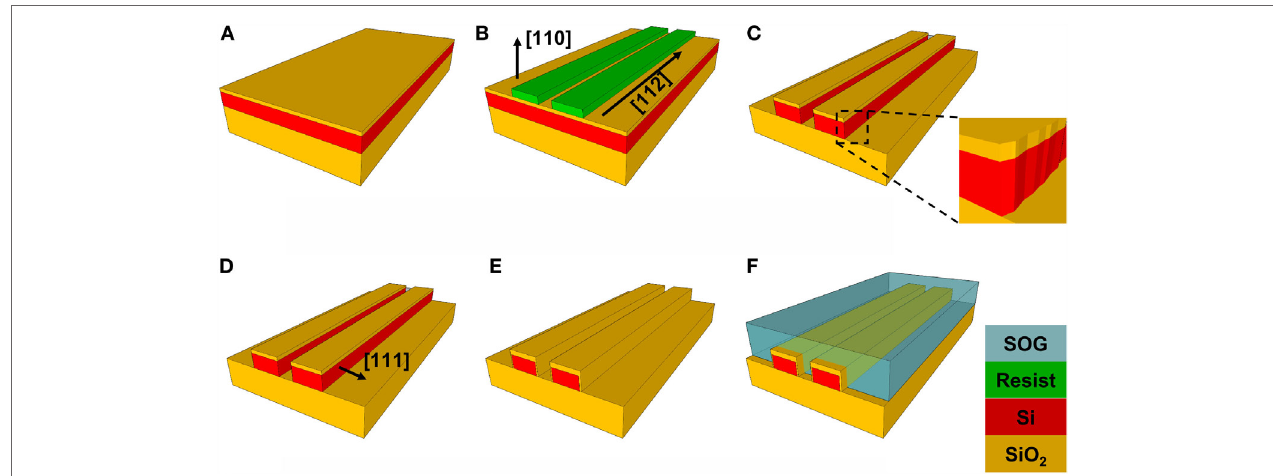
FigUre 2 | Fabrication process flow: (a) a 20-nm thick layer of siO 2 was thermally grown on sOi substrate; (B) slot and strip waveguide patterns were written on the resist layer using e-beam lithography; (c) waveguide patterns were transferred to the silicon layer using icP dry etching process; (D) sOi substrate was dipped into TMah solution to remove any surface roughness (only for sample B); (e) a thin siO 2 layer was thermally grown to serve as surface passivation; and (F) finally, 500 nm thick layer of sOg was spin coated and cured